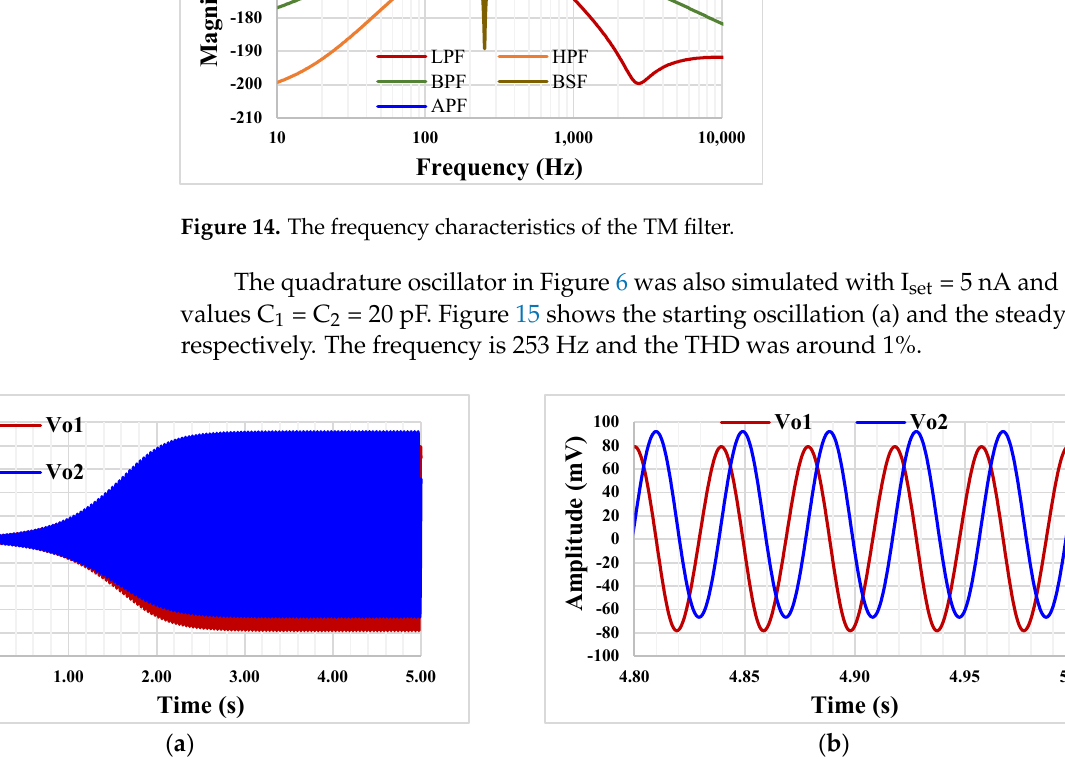
Figure 15. The starting oscillation ( a ) and the steady state ( b ).